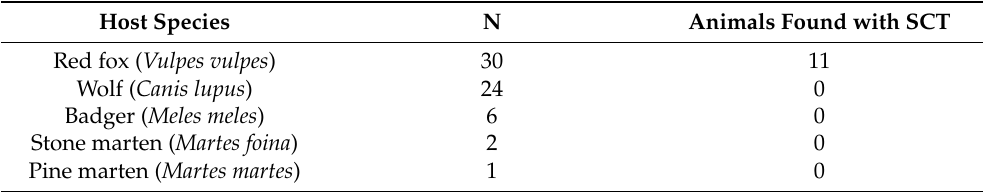
Table 1. Animal species examined in the present study and their infestation with SC ticks. Host Species N Animals Found with SCT Red fox ( Vulpes vulpes ) 30 11 Wolf ( Canis lupus ) 24 0 Badger ( Meles meles ) 6 0 Stone marten ( Martes foina ) 2 0 Pine marten ( Martes martes ) 1